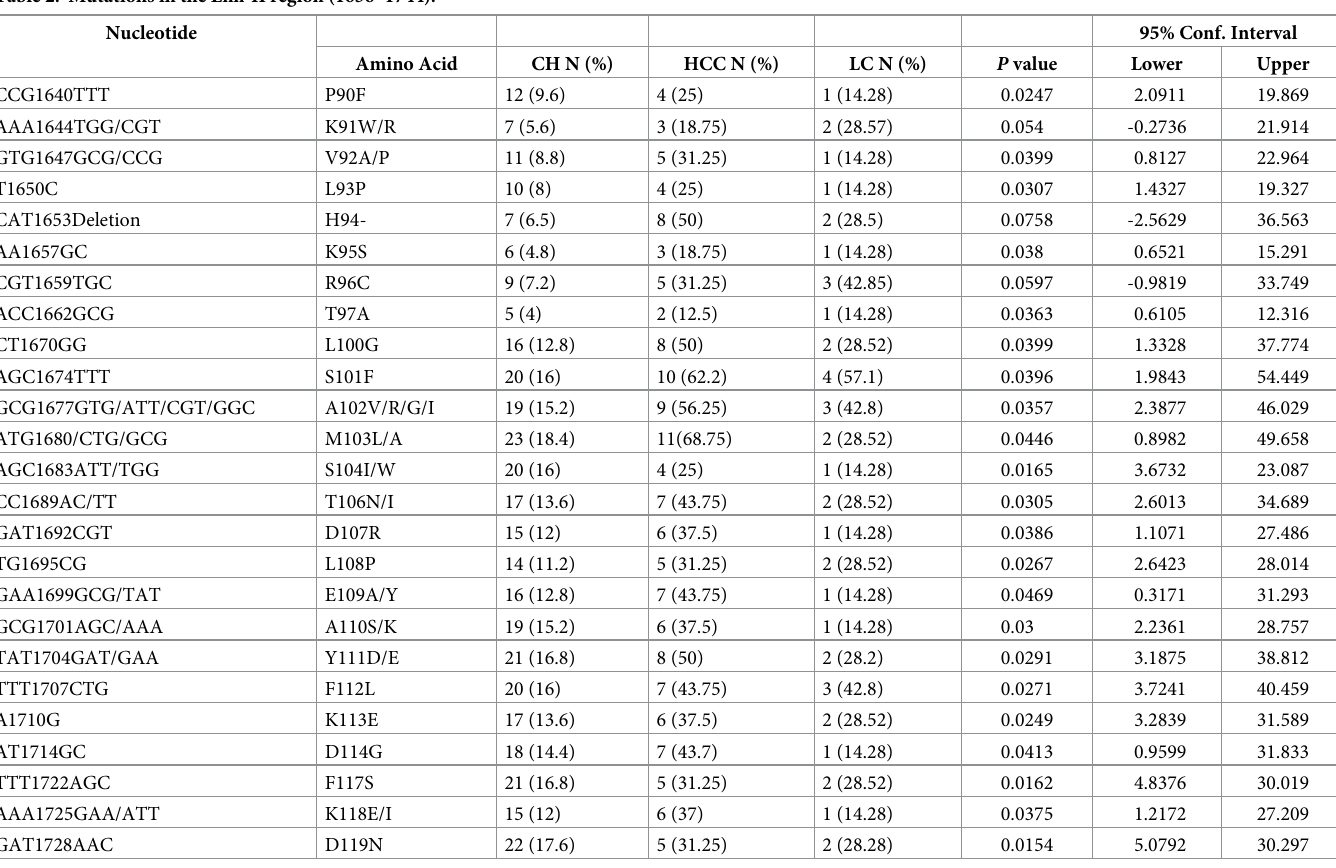
Table 2. Mutations in the Enh-II region (1636–1744). Nucleotide